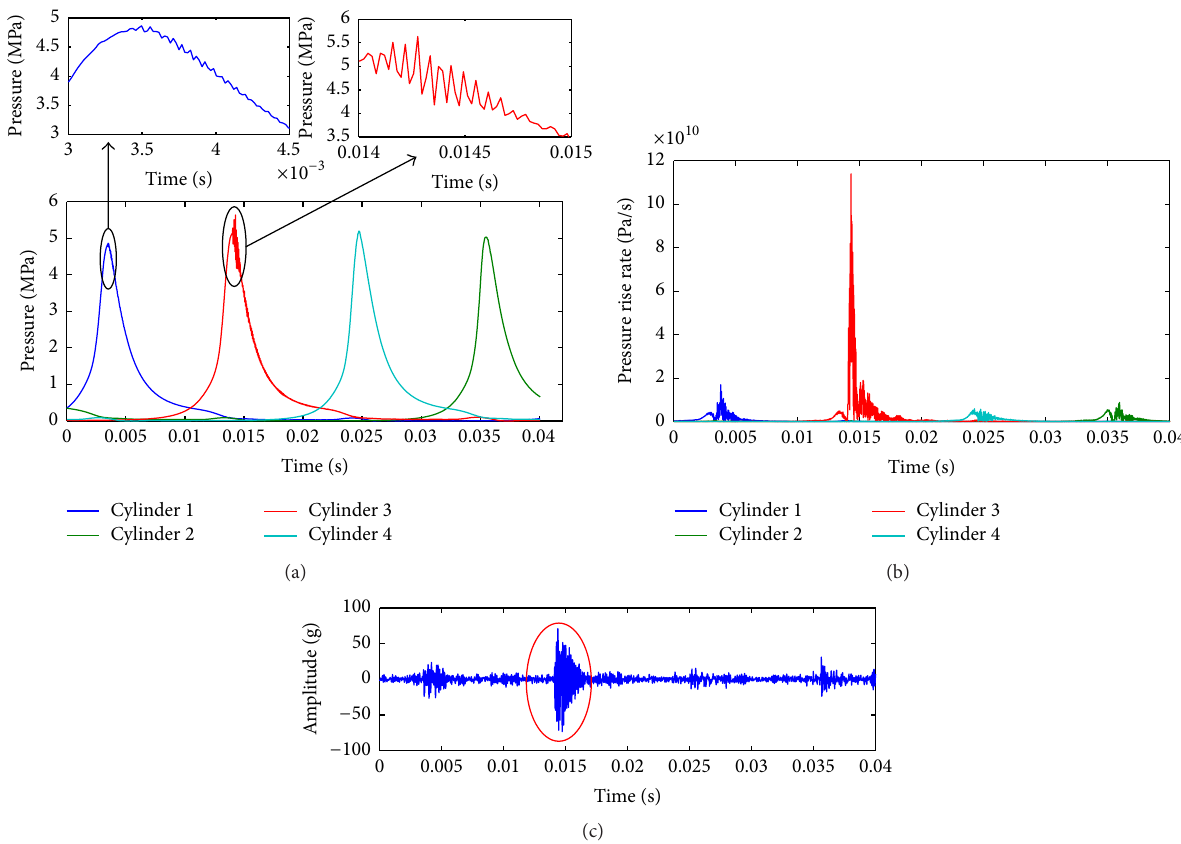
Figure 12: (a) Cylinder pressure signal under 2800 rpm. (b) Cylinder pressure increase rate under 2800 rpm. (c) Cylinder block vibration signal under 2800 rpm.